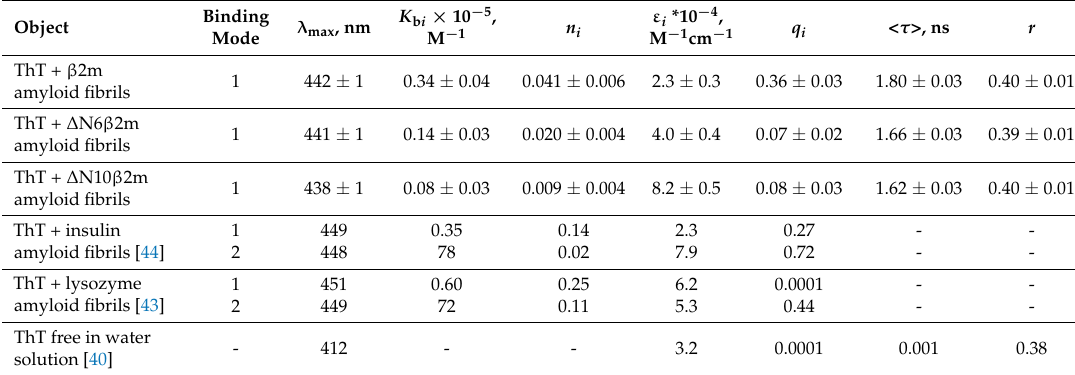
Table 1. Binding parameters of ThT to amyloid fibrils formed from different amyloidogenic proteins and characteristics of the bound